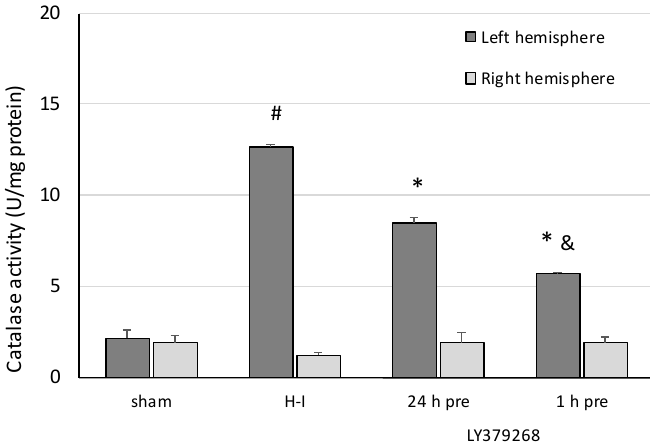
Figure 4. The effect of LY379268 pretreatment on changes in catalase activity evoked by H-I. The results are presented as the mean ± SD, n = 3–5; #—significantly different from the sham-operated group, p < 0.005; *—different from the H-I group, p < 0.005; &—different from the group injected 24 h before H-I, p < 0.01 .